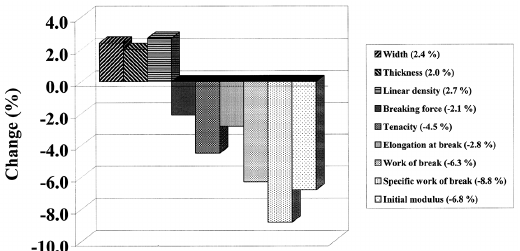
Figure 7: Changes in properties of tapes after application of additive Granic 422. tenacity, elongation at break, work of break, specific work of break and initial modulus. The above-mentioned negative changes in properties can be shown using the linear dependences. According to the relations, the tensile properties reduced in about